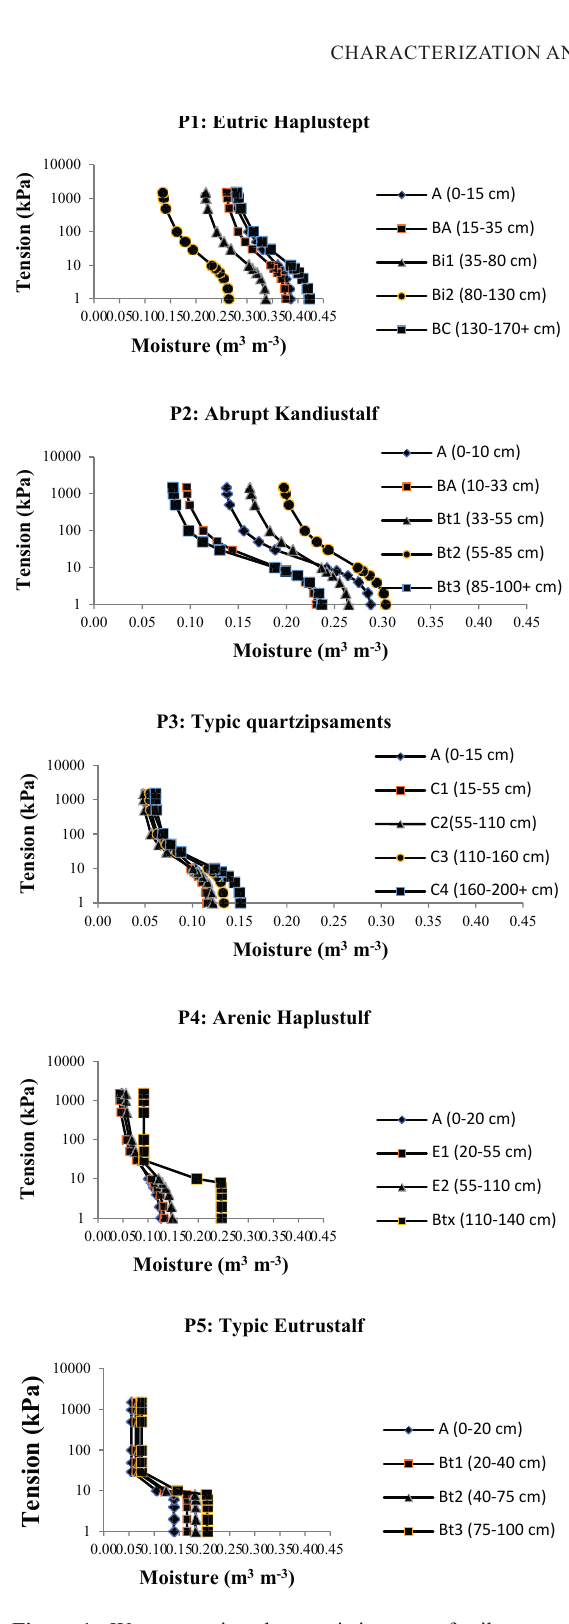
Figure 1 - Water retention characteristic curve of